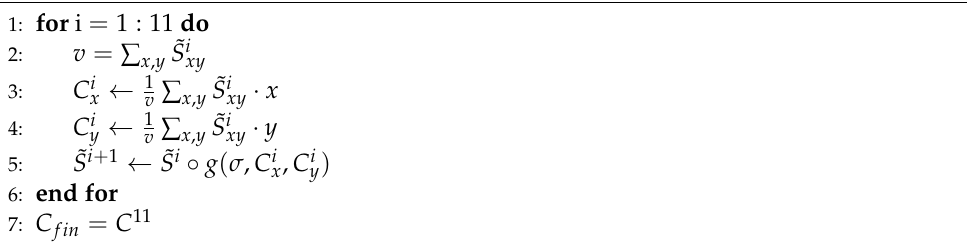
Figure 2. ˜ S 1 of Algorithm 3 ( a ) and ˜ S 11 with the calculated centroids displayed by circles, after 11 iterations (( b ), zoomed in). Algorithm 3 Iterative calculation of the mitral valve